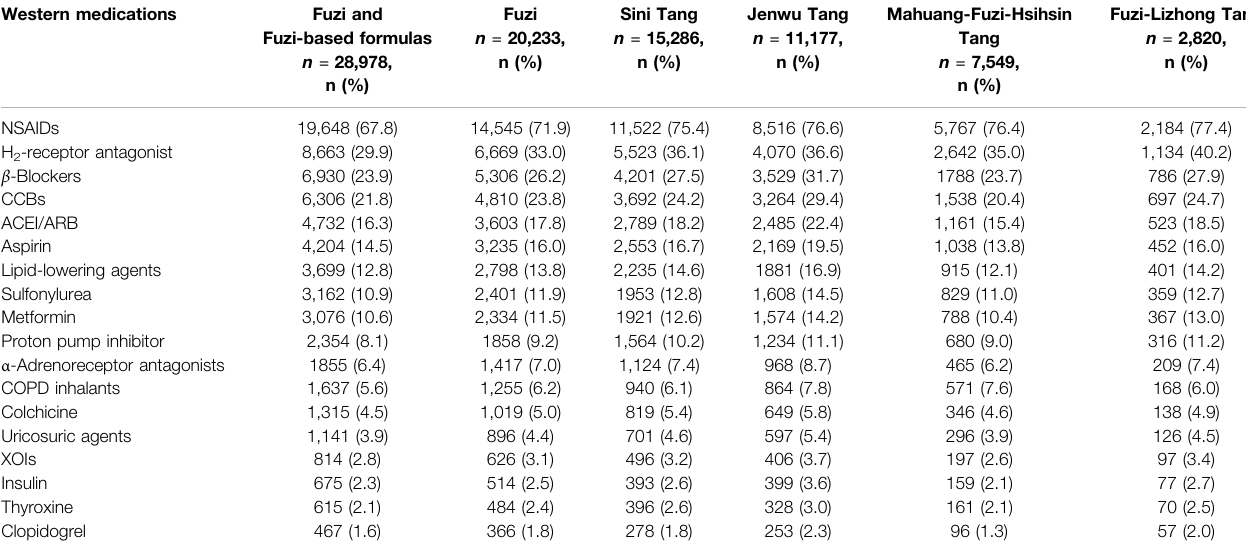
TABLE 3 | Common Western medications prescribed by Western medicine doctors in patients who long-term use Fuzi and Fuzi-based formulas. Western